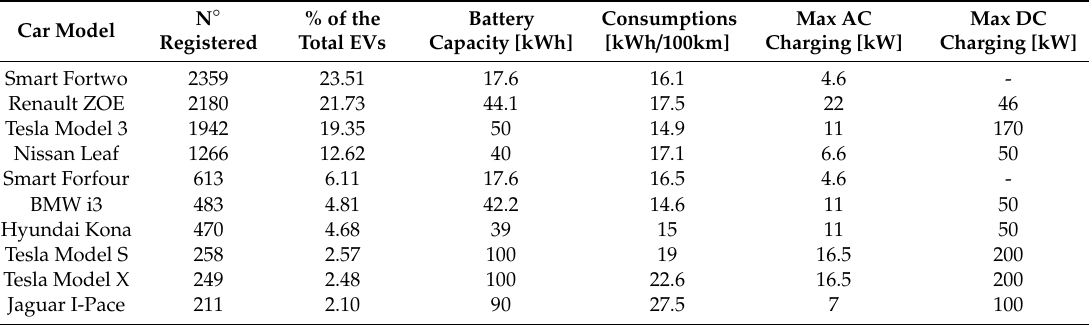
Table 1. Data of the EVs registered in Italy in 2019, source Italian association of foreign carmakers (UNRAE) [38], and the vehicles’ manufacturers